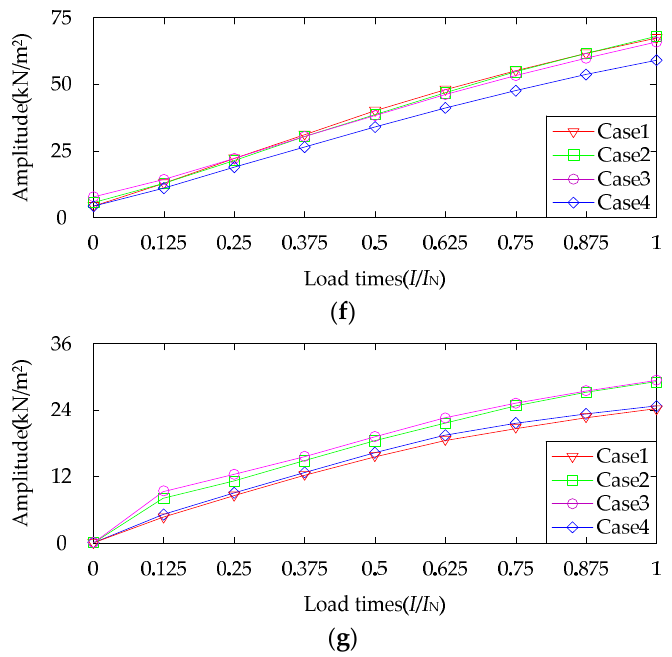
Figure 3. The amplitude curve of the radial electromagnetic force in the air gap with the load times (2D diagrams): ( a ) l = 2; ( b ) l = 4; ( c ) l = 6; ( d ) l = 8; ( e ) l = 10; ( f ) l = 12; ( g ) l = 14.